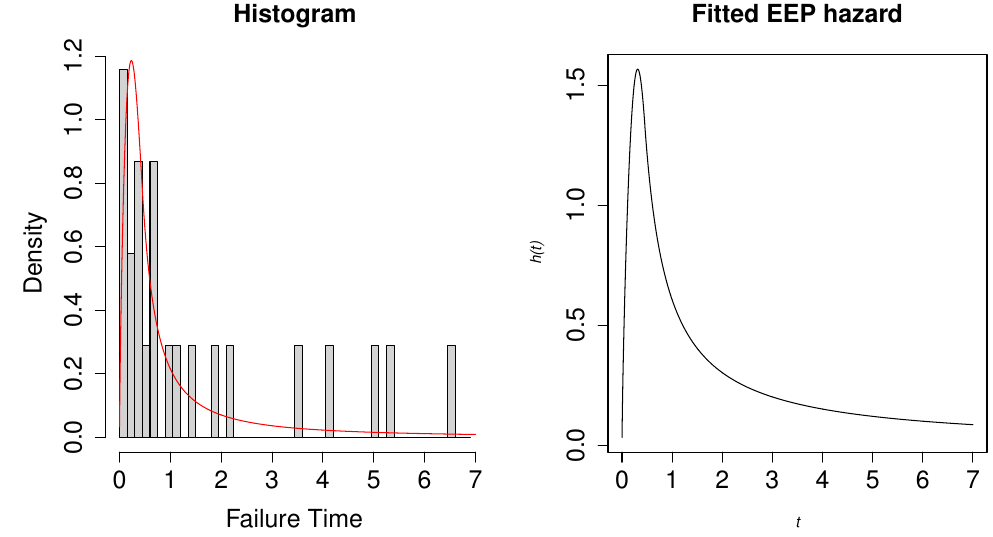
Figure 8. Fitted hazard function of EEP distribution for secondary reactor pumps data set.